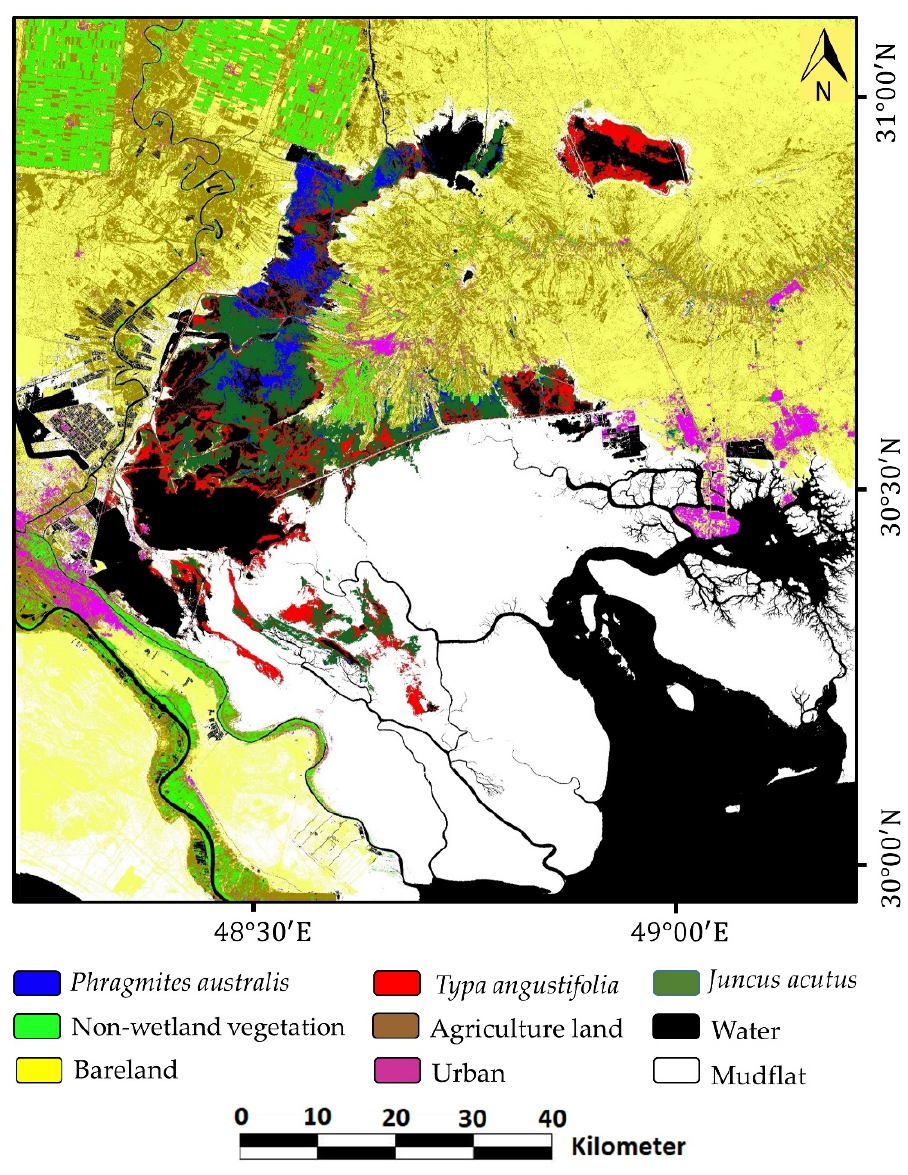
Figure 5. Wetland map generated for the reference year (2020) using a combination of Sentinel-1 and Sentinel-2 images and the RF classifier in GEE.